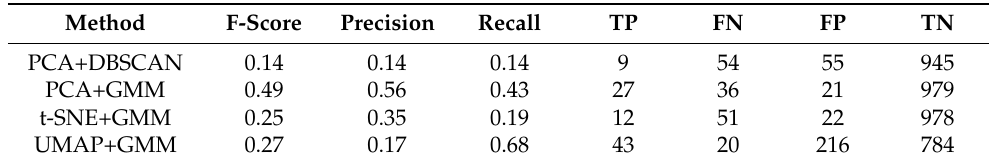
Table 2. Comparison of ML approaches for test Dataset 1a where ANCs are considered as True Anomalies.